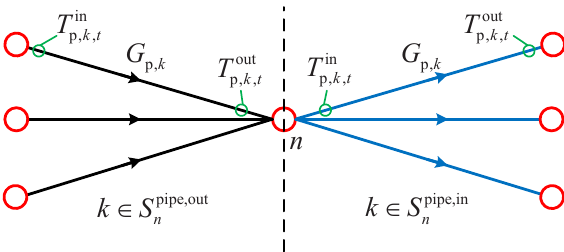
Figure 3. General structure of a node connecting with cross